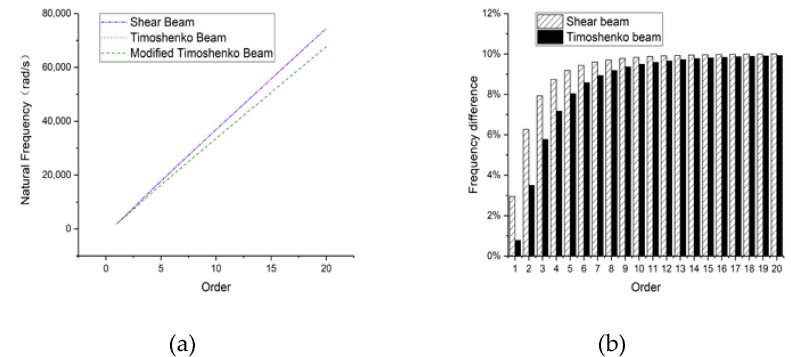
Figure 15. Natural frequencies of the 2-m-long beam: ( a ) overall frequency curve and ( b ) frequency di ff erence compared with a modified Timoshenko